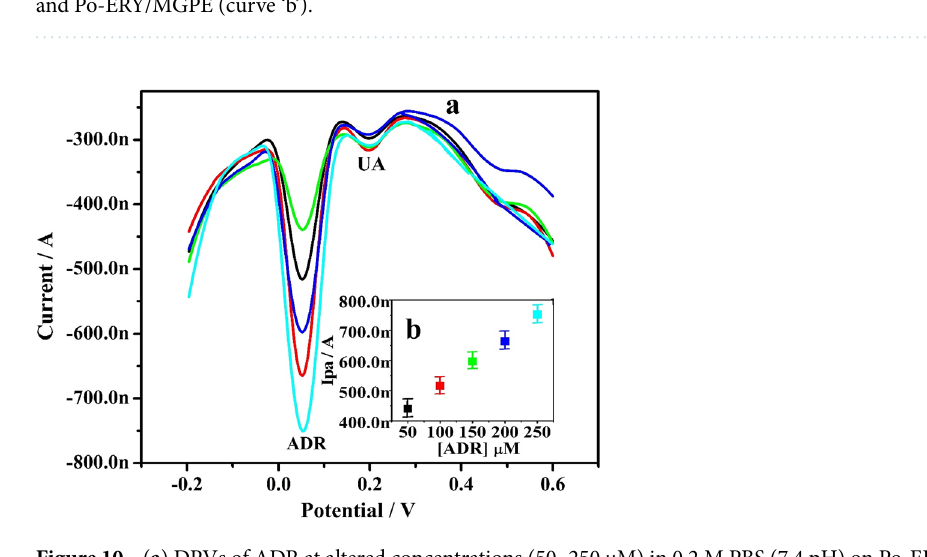
Figure 10. ( a ) DPVs of ADR at altered concentrations (50–250 µM) in 0.2 M PBS (7.4 pH) on Po-ERY/MGPE. ( b ) Plot of Ipa Vs concentration of ADR.